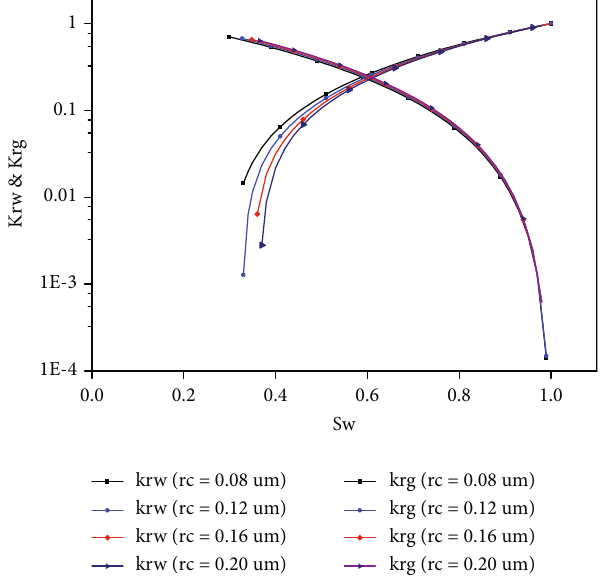
Figure 12: Relative permeability curves with di ff erent minimum fl ow channel